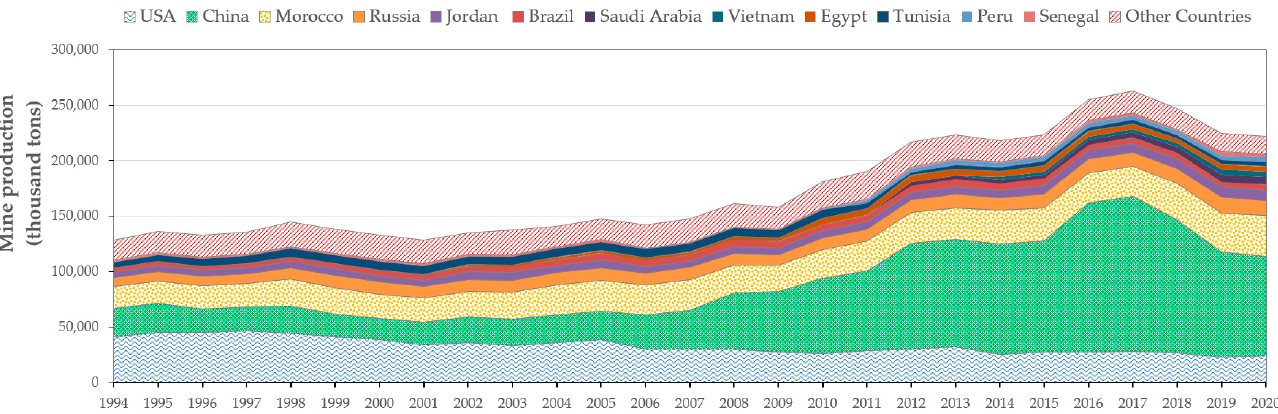
Figure 2. Phosphate rock production by country. Source: data compiled from USGS database, 1994–2020.